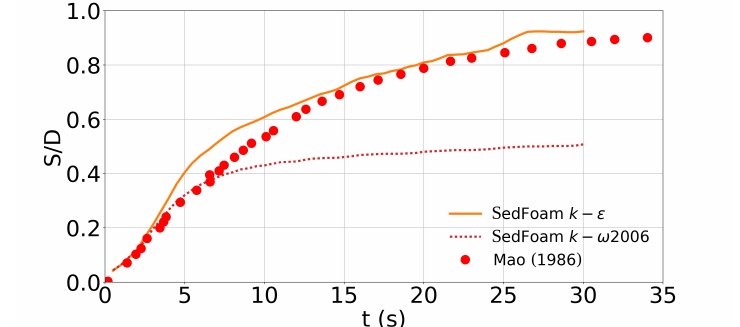
Figure 4. Time evolution of the maximum scour depth from simulations with the µ ( I ) rheology using the k − ε (orange line) and k − ω 2006 (red dotted line) turbulence models compared with the experimental data from Mao (1986) [2] (red dots).